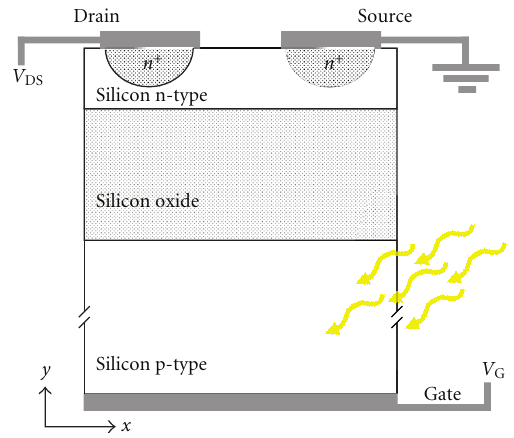
Figure 1: Schematic cross section of the SOI-PAM device. Like in a field e ff ect device the information current flows through silicon channel that is limited by two terminals (source and drain). The source is connected to ground. Gate voltage V G is applied at su ffi cient rate to bring the substrate into its deep depletion mode. An oblique illumination generates charges in the p-type